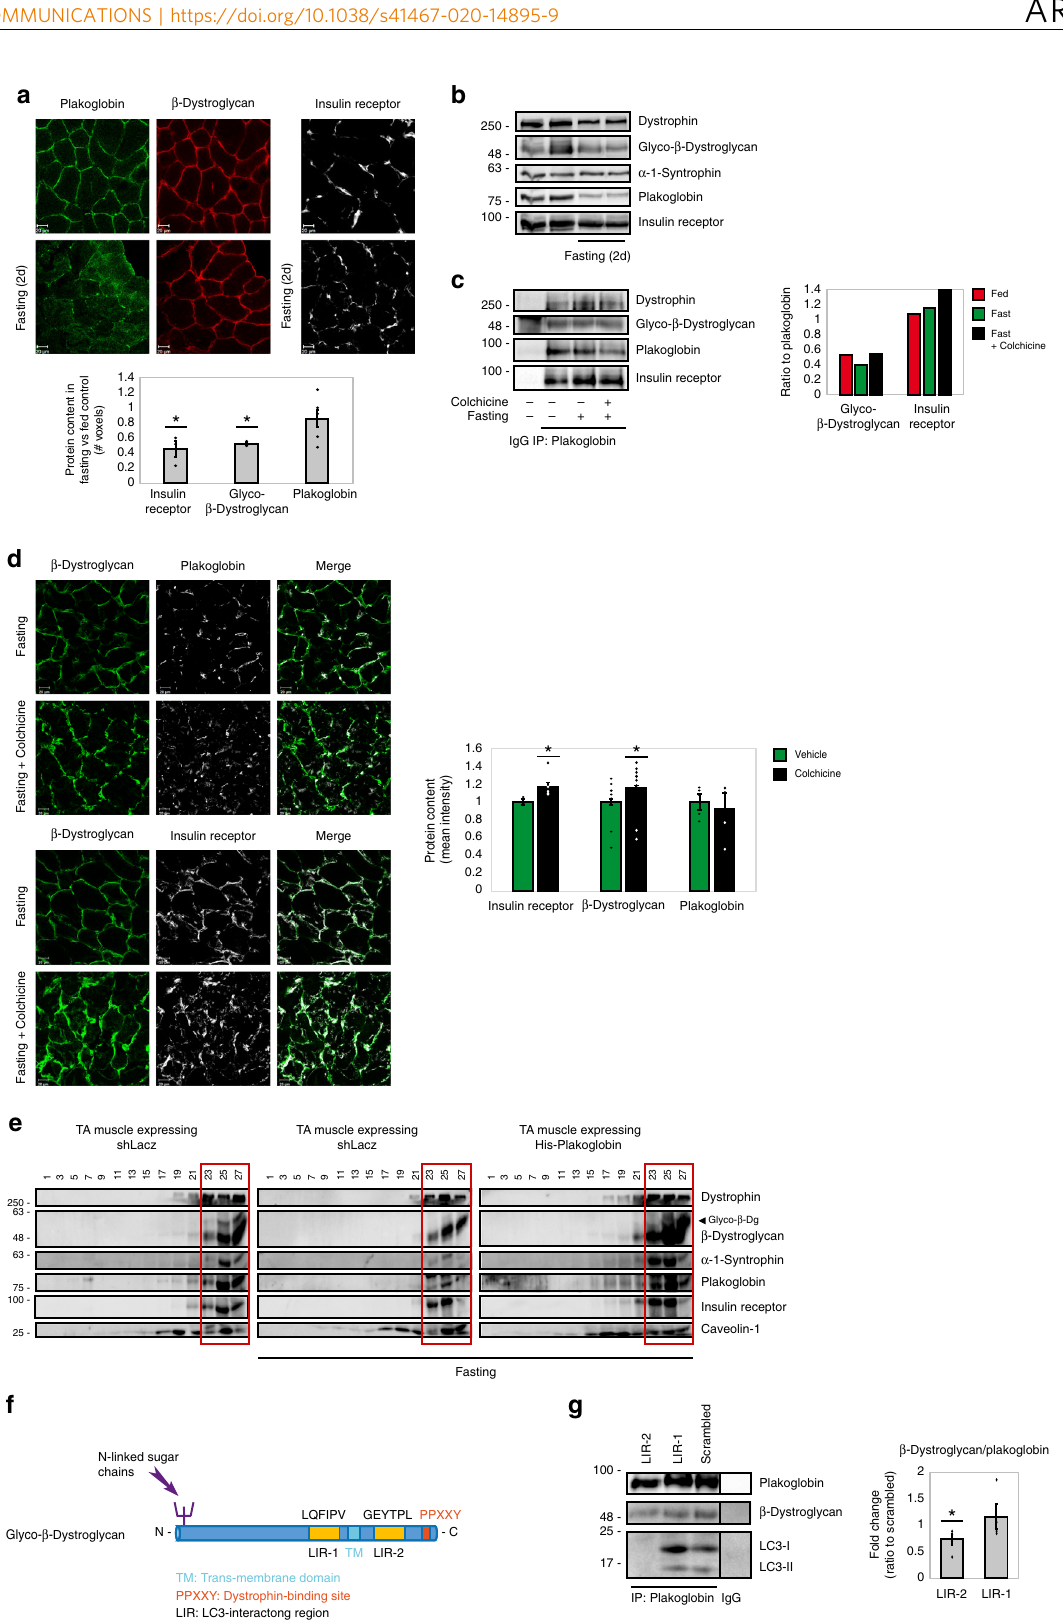
LC3 when autophagy is induced and plakoglobin-DGC-insulin receptor clusters are lost. It is noteworthy that the overexpressed GFP- β -dystroglycan may colocalize with endogenous insulin receptor and plakoglobin proteins in different proportions, as